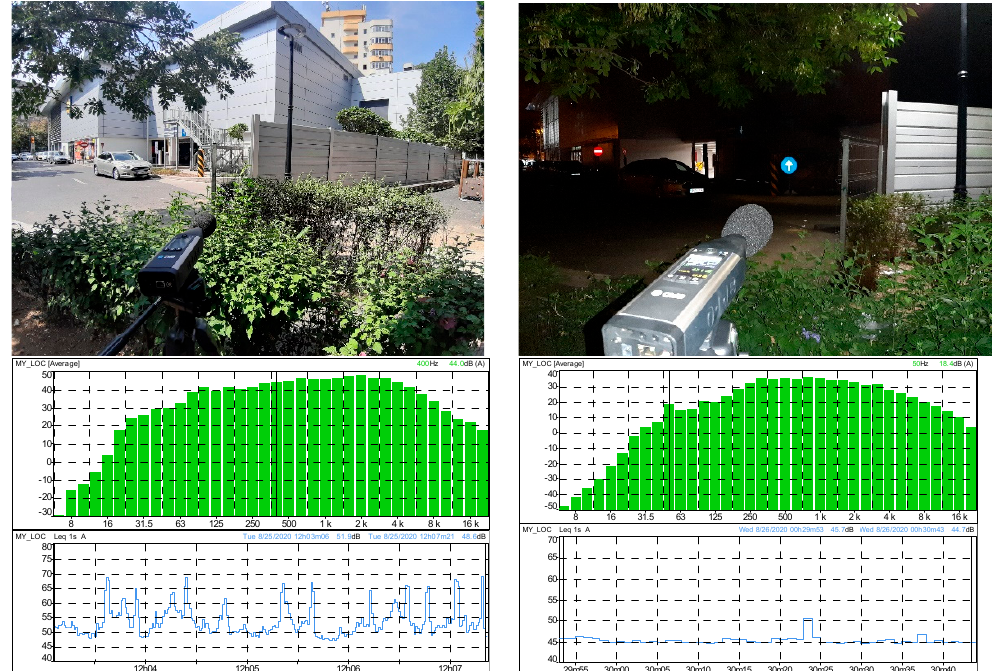
Figure 16. Analysed area ( left : before constructing the shopping centre, right : after the construction).